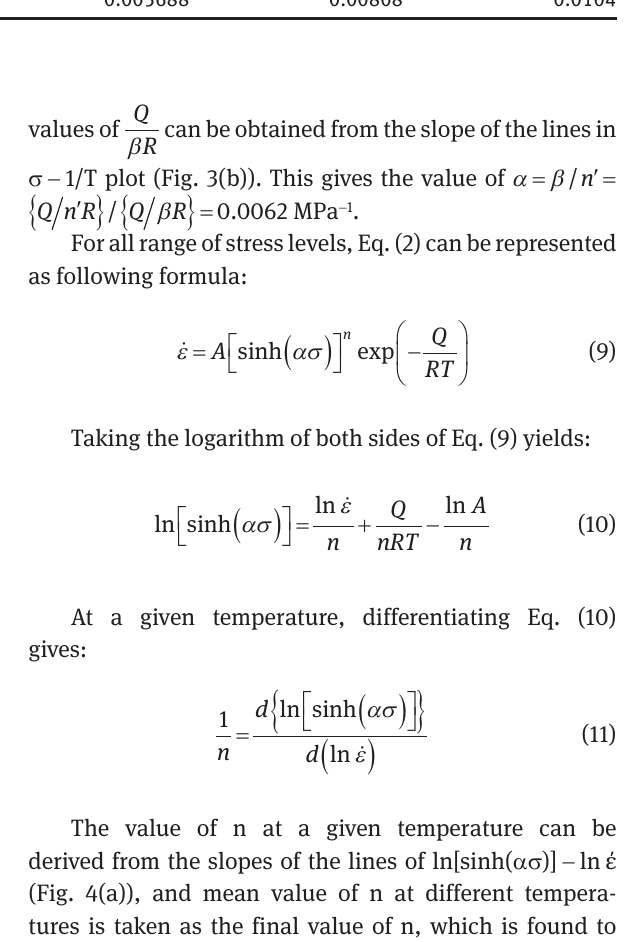
Table 2: Hot compression deformation parameters of FV520B steel at different temperatures Parameter 900 °C 950 °C 1000 °C 1050 °C 1100 °C ′ n